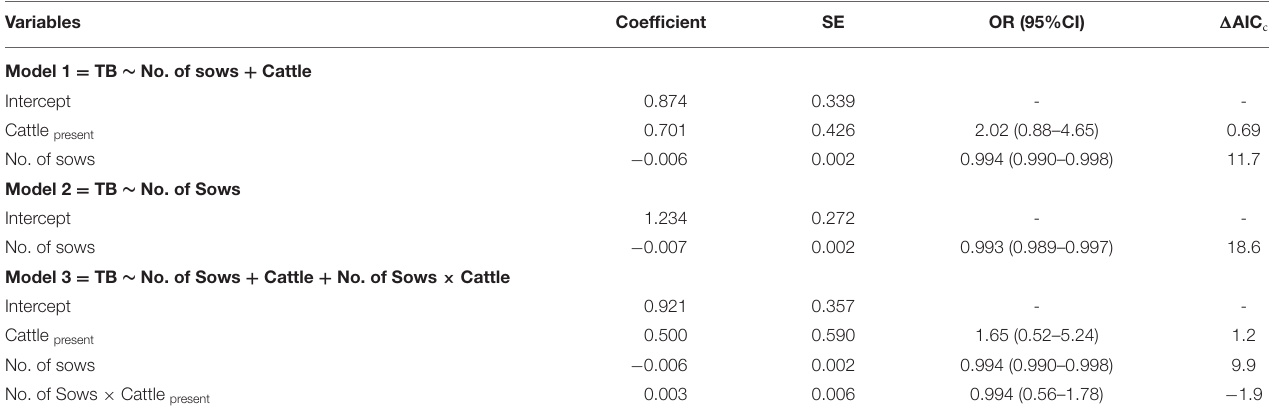
TABLE 1 | Parameters of the three candidate logistic models showing the association between risk factors and confirmation of sample TB positive status ( n = 133).